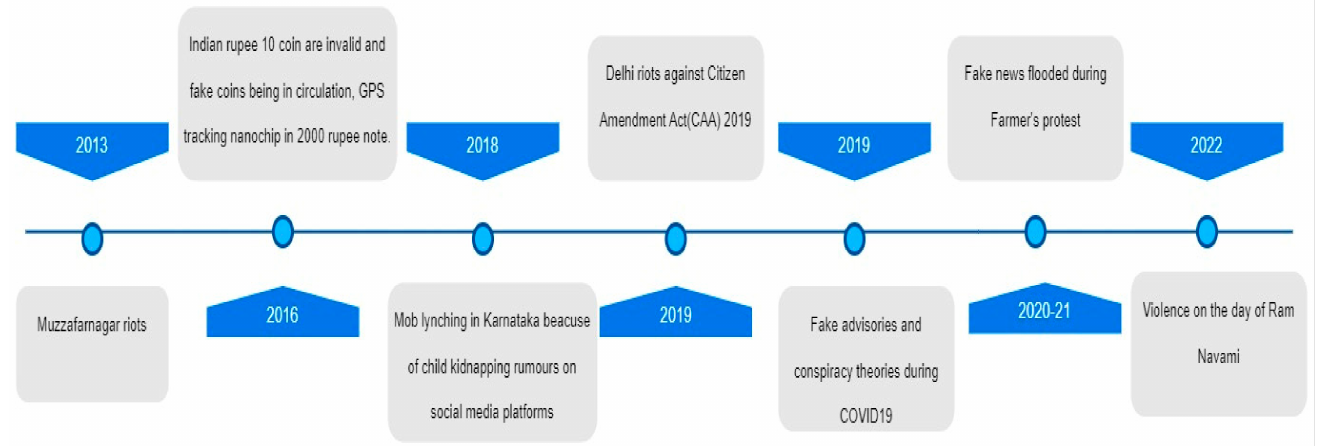
Figure 1. Timeline: many instances of fake news